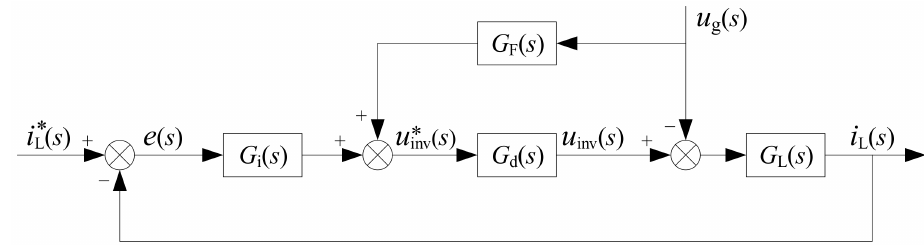
Figure 2. Control diagram of the current loop for the